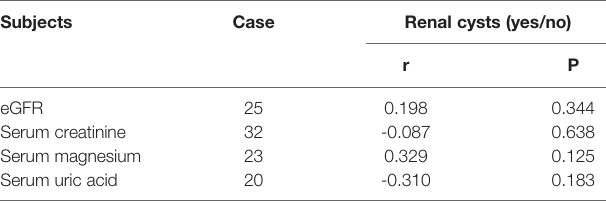
TABLE 1 | Spearman ’ s correlation analysis evaluating the association between serum parameters and renal cysts of MODY5 patients.